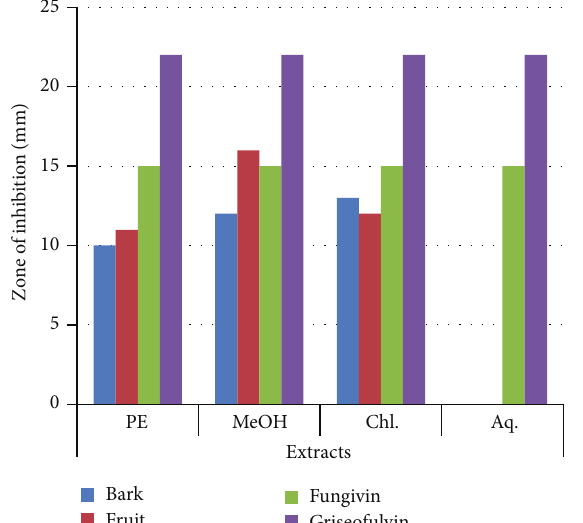
Figure 10: MIC values (mg/mL) exhibiting potential of bark and fruit of C. ambrosioides against S. aureus .